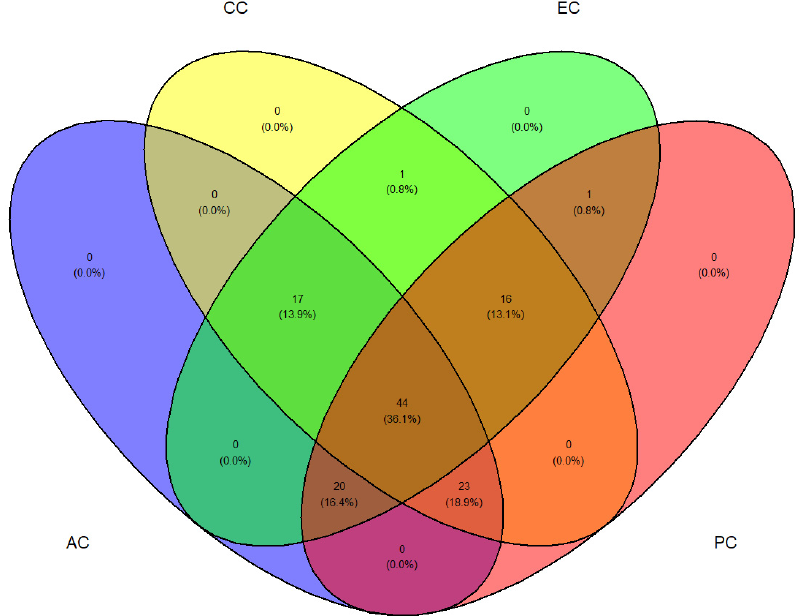
Figure 3. Venn diagram distribution of nutritional and phytochemical metabolites in Australian coffee (AC), Colombian coffee (CC), Ethiopian coffee (EC) and Peruvian coffee (PC).